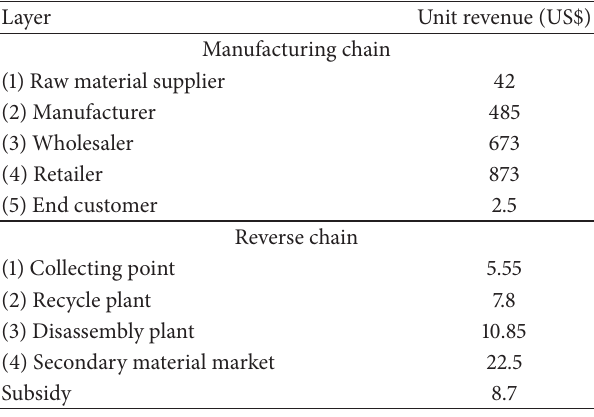
Table 1: Estimates of unit revenues.